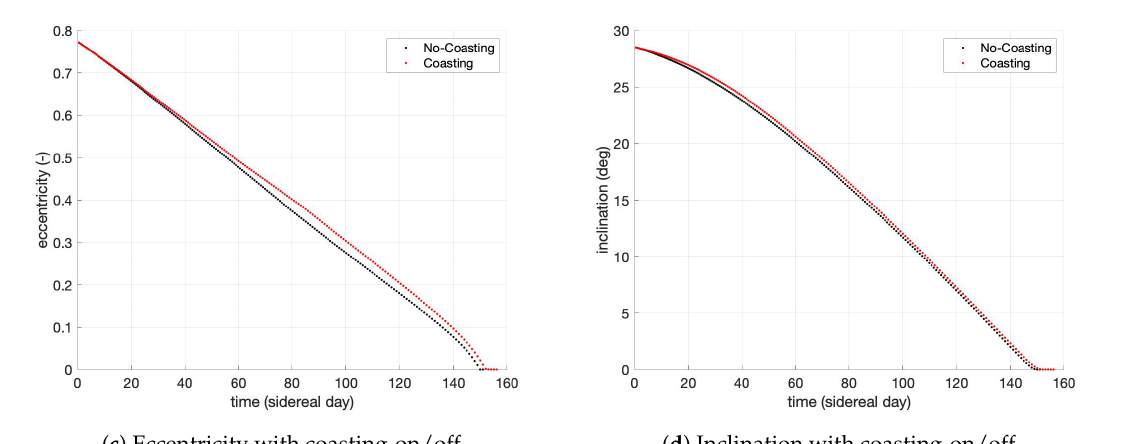
Figure 13. Osculating orbital elements of Super-GTO to GEO